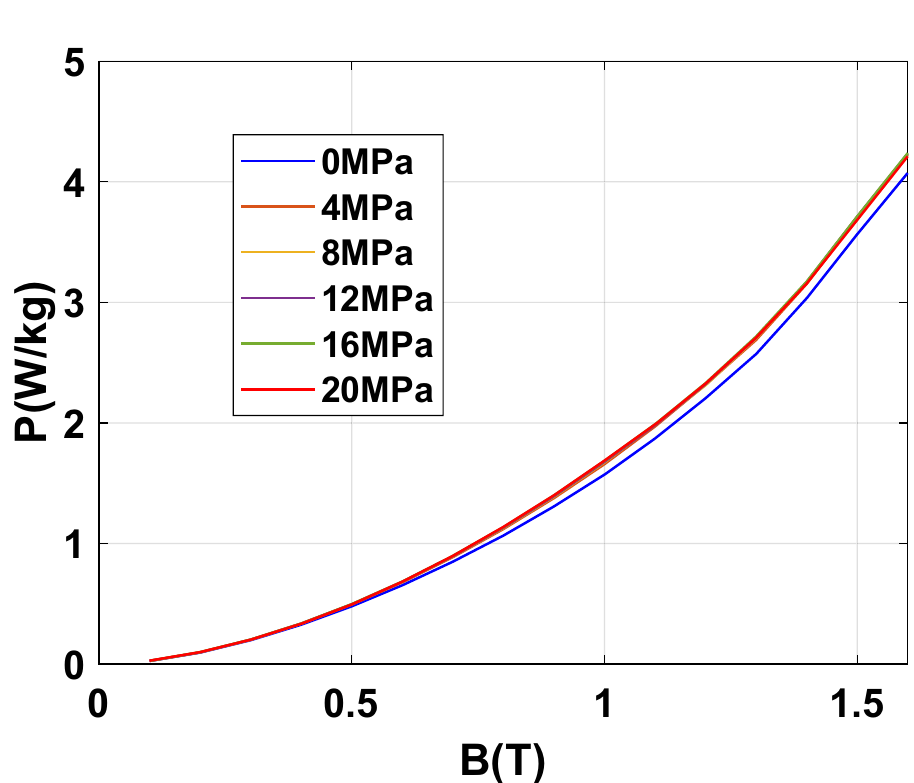
Figure 17. Iron losses 50 Hz - Homogeneous